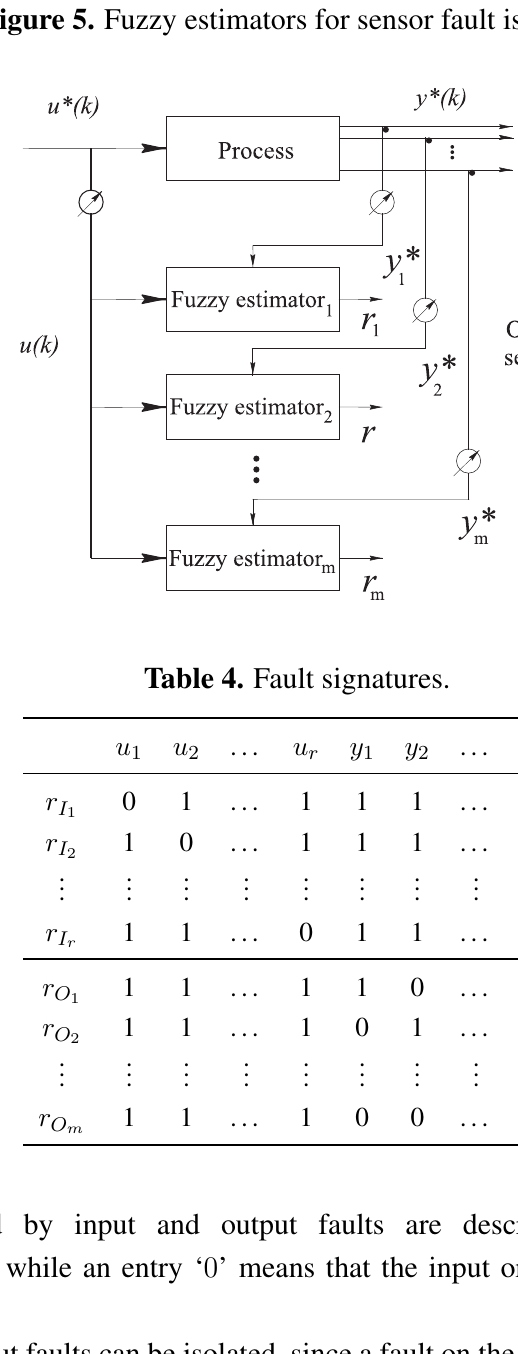
Figure 5. Fuzzy estimators for sensor fault